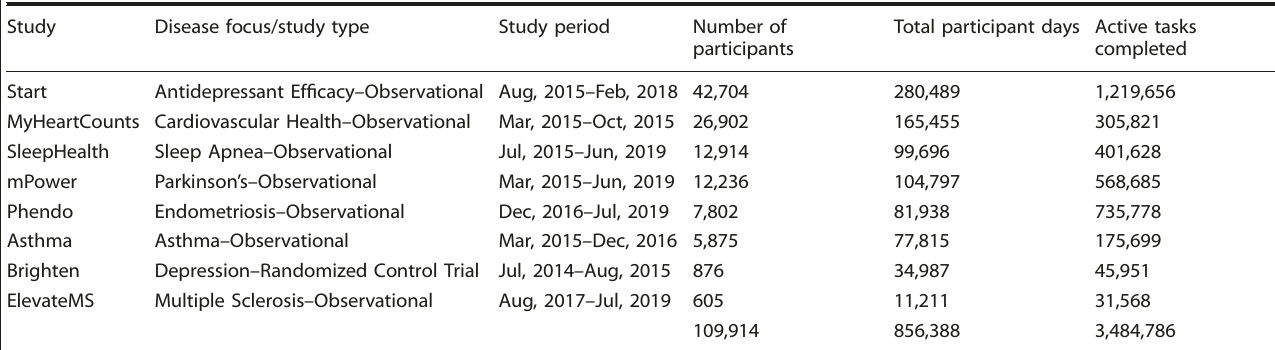
Table 1. Summary of user-engagement data compiled from eight digital health